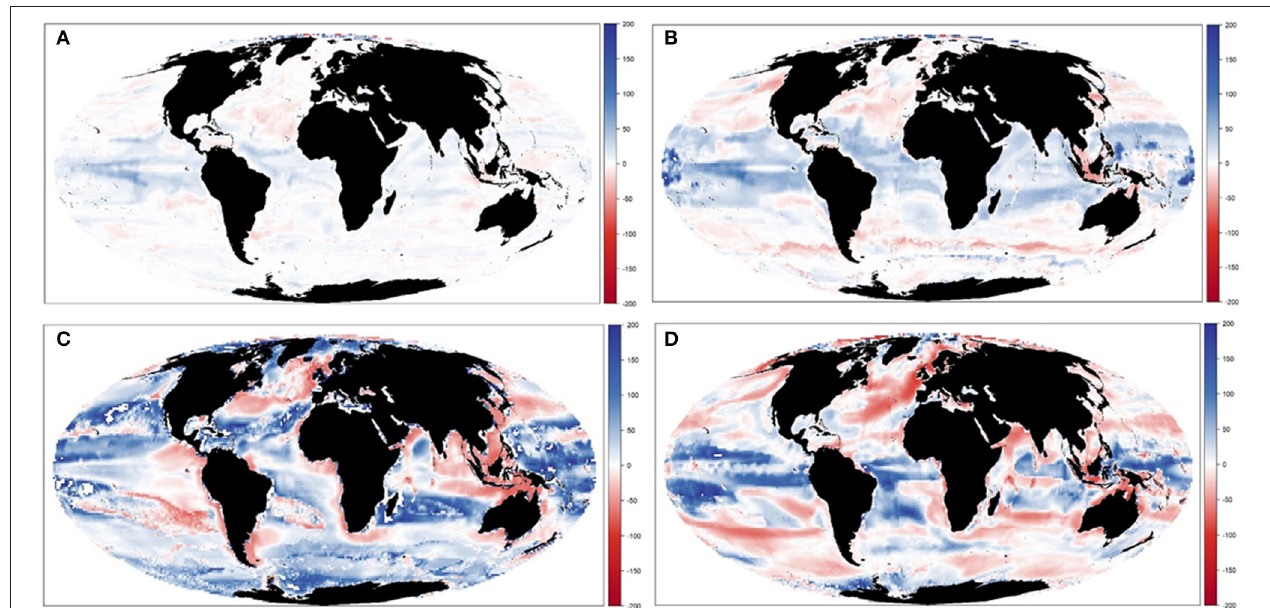
FIGURE 8 | Experiment 2 (Climate impacts) and 3 (Climate impacts and fishing impacts) ( Table 1 )—Relative temporal biomass change (%) of functional groups: (A) “Large reef fish”, (B) “Small reef fish,” (C) “Large sharks,” and (D) “Small and medium size sharks.” (Fish images source: IAN, 2020).